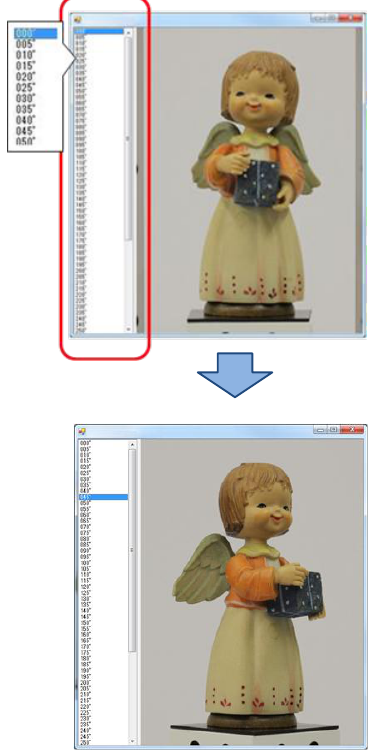
Altitude is constant.